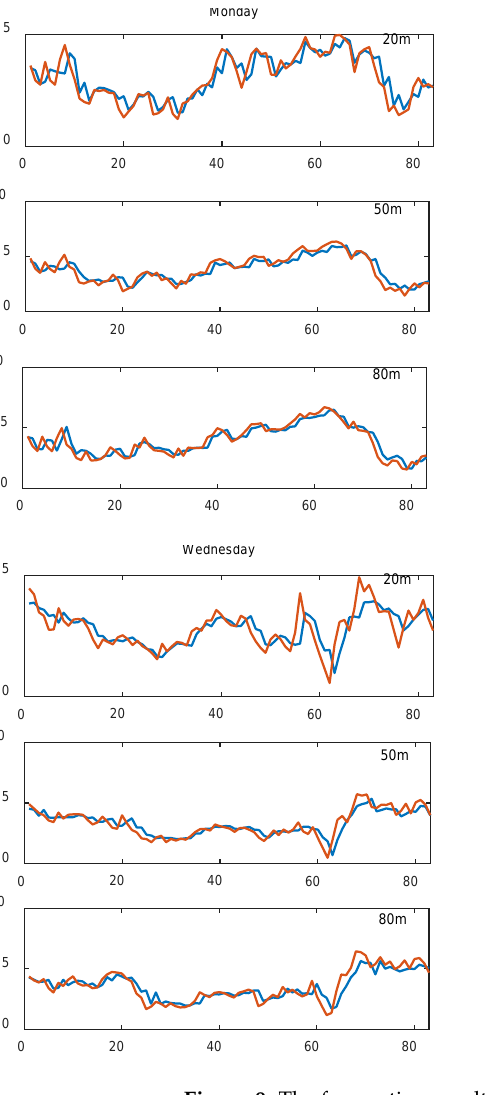
Figure 9. The forecasting results of the ELM–Elman–LSTM model and the observation of wind speed.